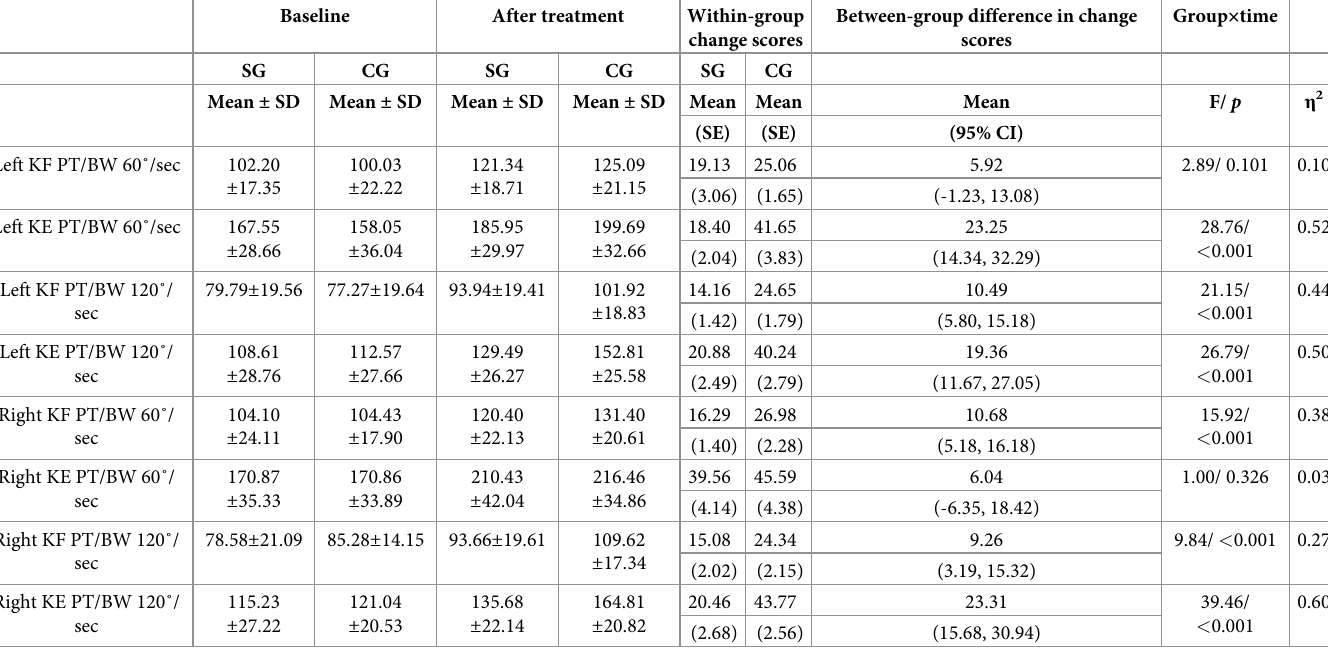
Table 4. Baseline, post-intervention and change scores for the knee flexor-extensor muscle strengths.